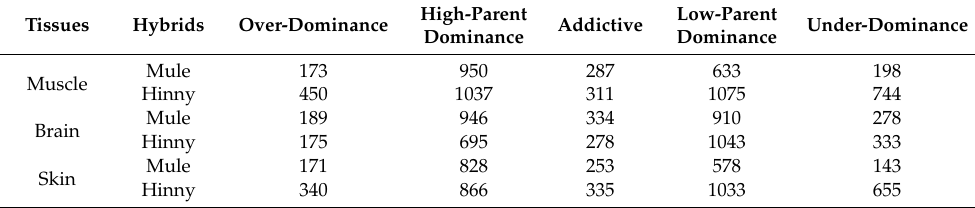
Hybrids represent mule or hinny; P, paternal lines represent male horse or male donkey; M, maternal lines